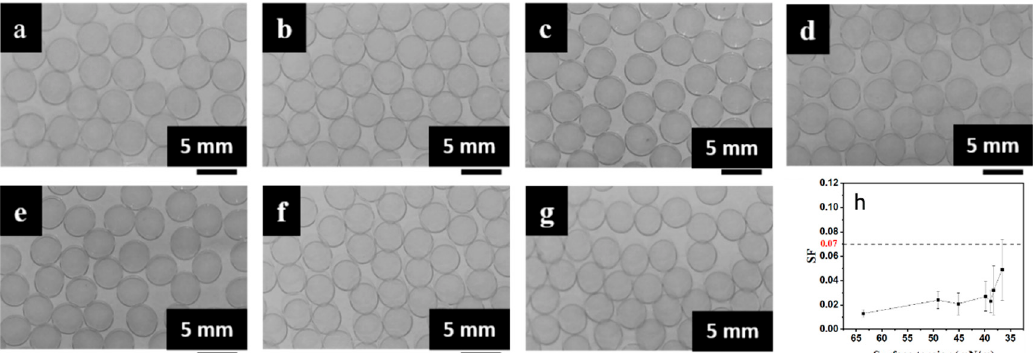
Figure 8. Images of the mm-CaSA-Caps prepared at different surface tensions of CaCl 2 /CMC/Tween 80 solution ( a ) 63.61 mN/m, ( b ) 49.07 mN/m, ( c ) 45.14 mN/m, ( d ) 39.85 mN/m, ( e ) 38.86 mN/m, ( f ) 38.29 mN/m, ( g ) 36.63 mN/m and ( h ) SF of the mm-CaSA-Caps. The concentration of SA was 0.5 wt.%. The concentration of CaCl 2 was 1.5 wt.%. The concentration of CMC was 1.0 wt.%. The concentrations of Tween 80 were 0, 0.015, 0.025, 0.038, 0.075, 0.15 and 0.3 g/L.